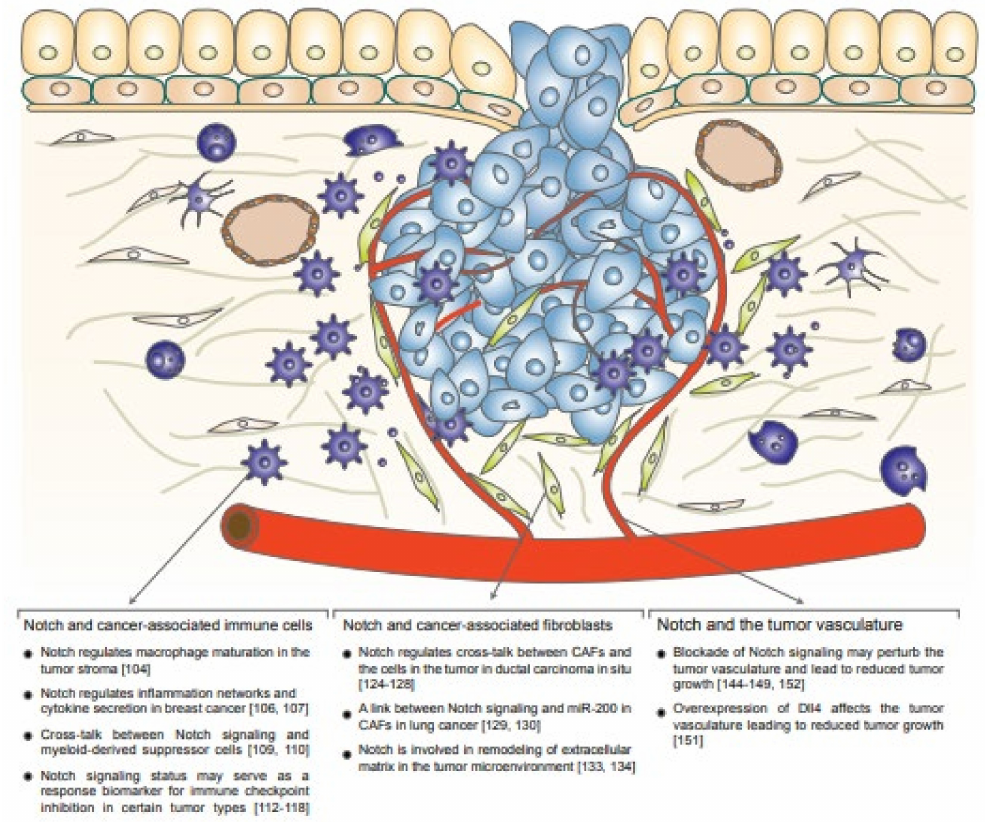
Figure 3. Notch and the tumor microenvironment. A schematic depiction of a tumor with its surrounding stroma. Three cell types are highlighted: cancer-associated fibroblasts, cancer-associated immune cells in the stroma and cells of the tumor vasculature. Below, examples of interactions between Notch signaling and the tumor microenvironment are provided. Numbers in brackets refer to references in the reference